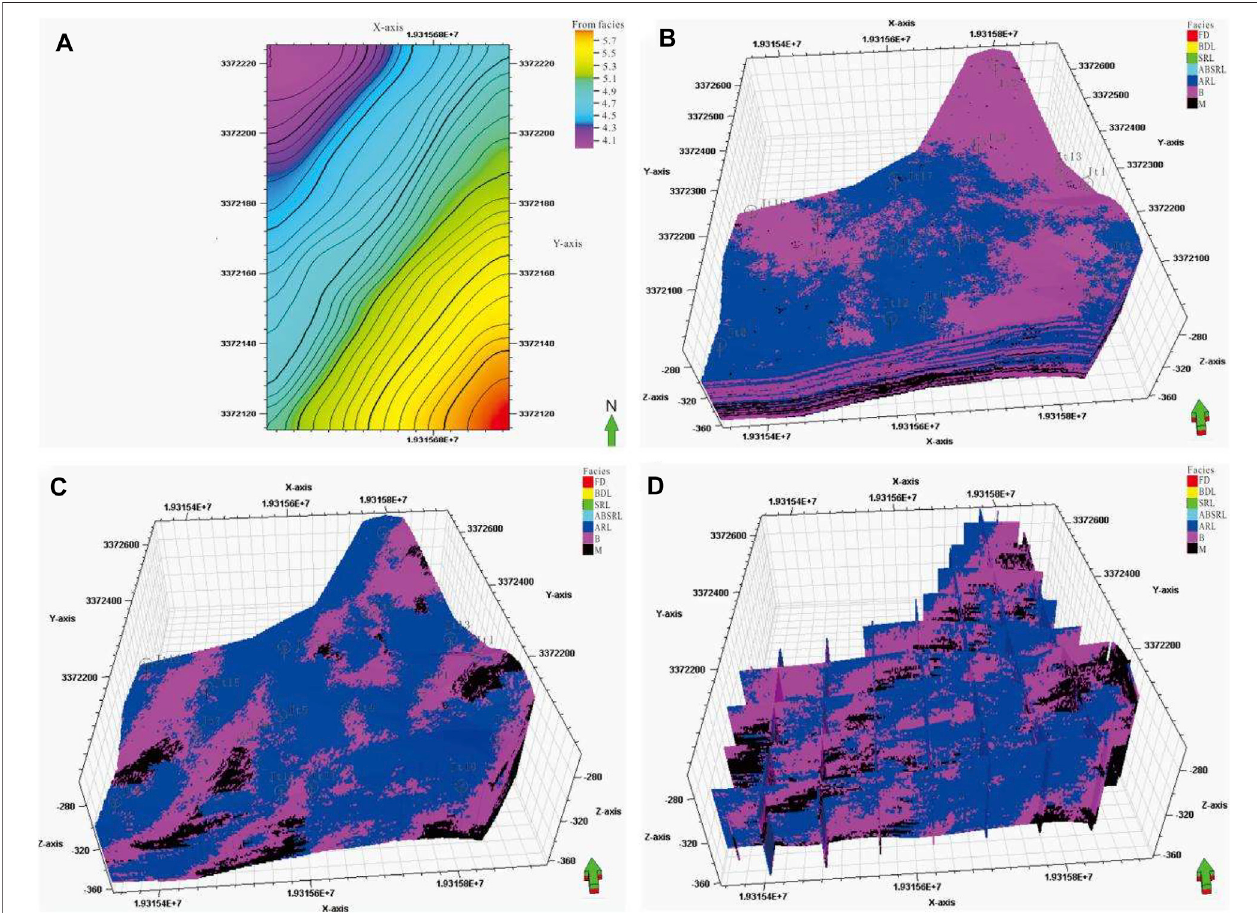
FIGURE 12 | 3-D outcrop modeling of reef base microfacies, which are restraint by training image pattern. (A) Reef base training image obtained by SIS, which deposited carbonate lithofacies gradually to bioherm; (B) the SIS Lithological modeling; (C) MPS realization; (D) palisade 3-D grids display about the multipoint geostatistics